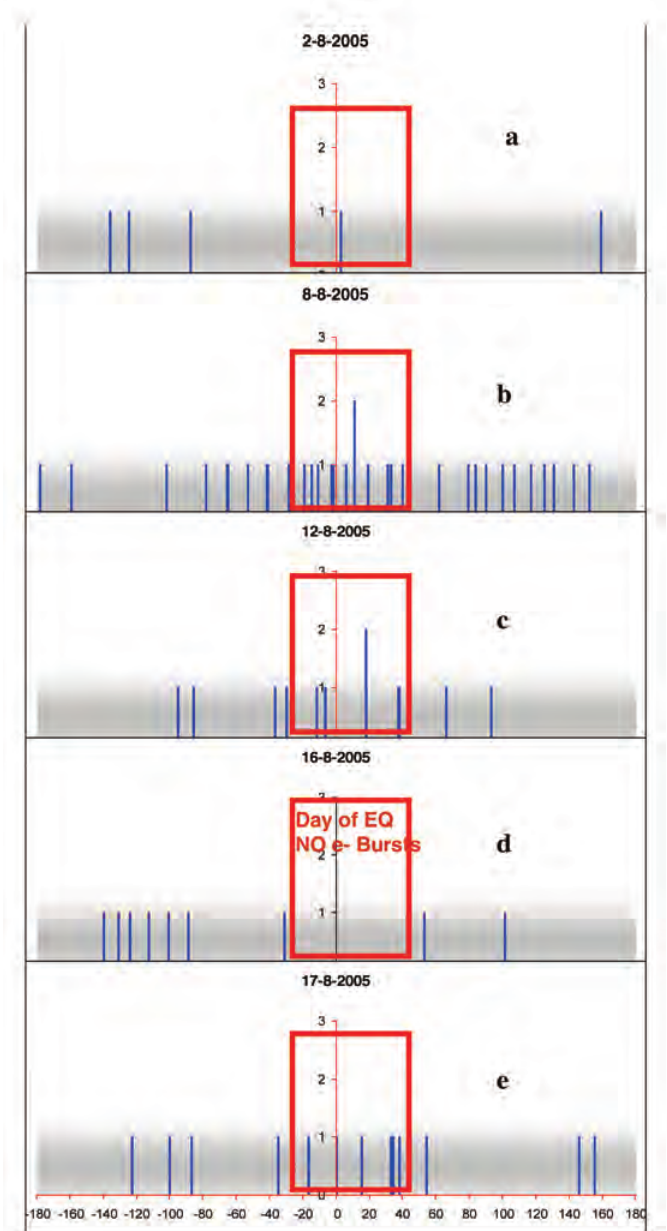
Figure 7. Distribution of electron bursts recorded by DEMETER as a function of longitude for selected days before the Japan August 16, 2005, earthquake. Longitude with a value (cid:0) i = 0 0 has been defined as the longitude of the of the earthquake epicenter. Characteristics of the temporal evolution and the spatial distributions of the bursts are discussed in the